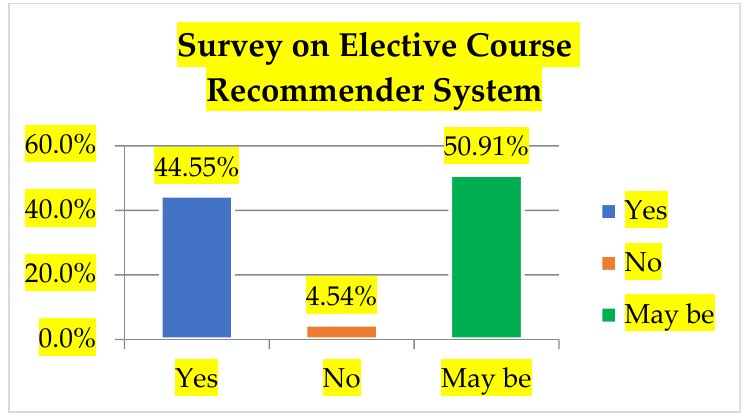
Figure 2. Students’ insight on course recommendation.